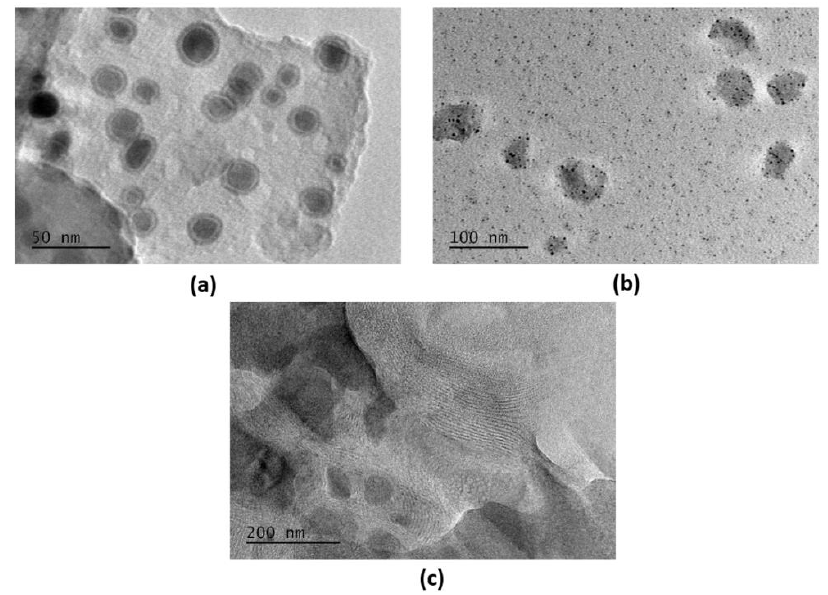
Figure 6. TEM images of the magnetic hybrid mAC-snack with scale bar = 50 nm ( a ), 100 nm ( b ) and 200 nm ( c ).